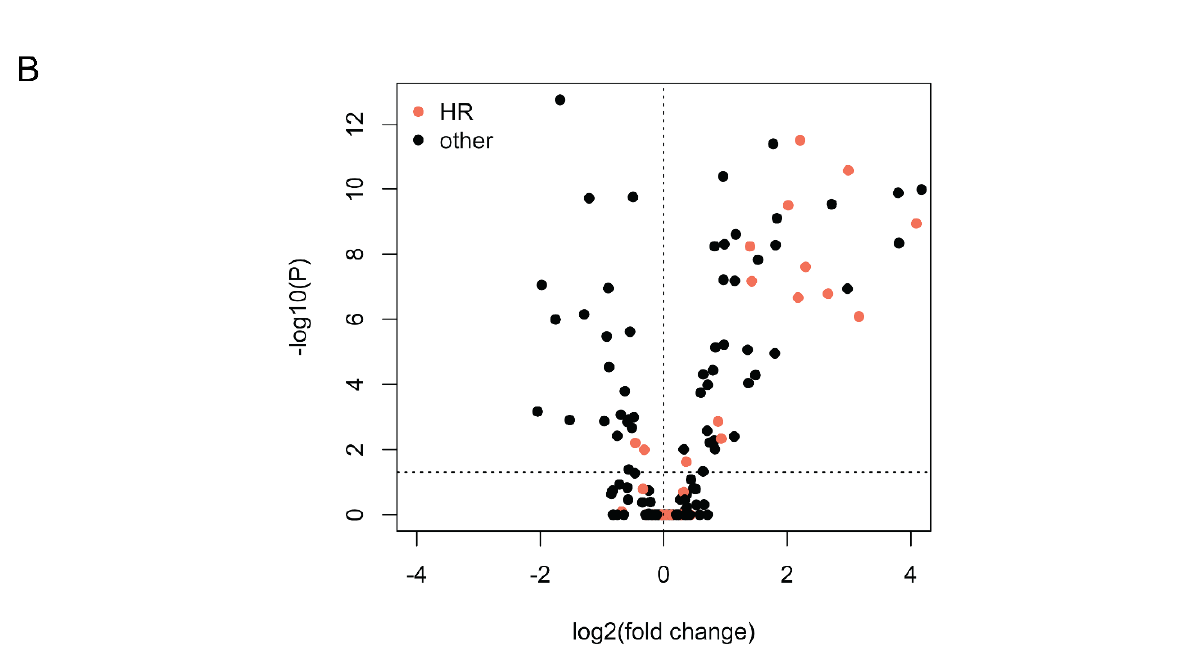
Figure 2. Expression profile of DNA damage and repair genes in 11 normal fallopian tube and 38 tumor samples analyzed with the NanoString nCounter assay. ( A ) Heatmap for mRNA counts obtained with the NanoString nCounter assay for DNA damage and repair genes in 11 normal fallopian tube and 38 tumor samples. Genes are depicted in rows and samples in columns. Both rows and columns have been hierarchically clustered based on Spearman correlations. Normal fallopian tube (FT) samples are labeled in grey, whereas tumor samples (T) are labeled in blue. Note that the data have been scaled and centered in rows (setting the row mean to 0 and the row standard deviation to 1) in order to normalize for differences in probe efficiencies. Tumor and fallopian tube samples cluster separately, with markedly different expression patterns. ( B ) Differential expression of DNA damage repair genes between tumor and fallopian tube samples, as determined